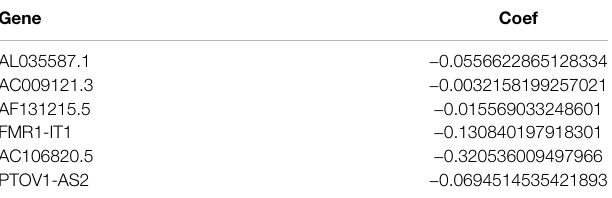
TABLE 2 | The correlation coef fi cient of m 6 A/m 5 C/m 1 A-related lncRNAs. Gene